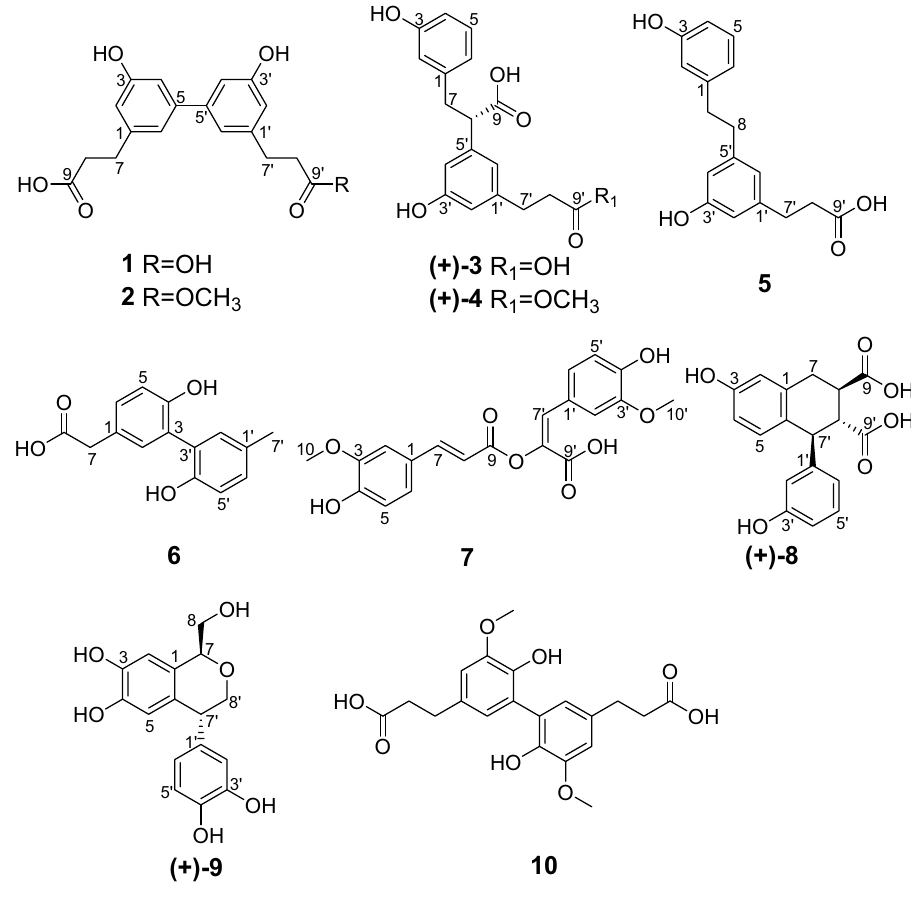
Fig. 1 The chemical structures of compounds 1 –